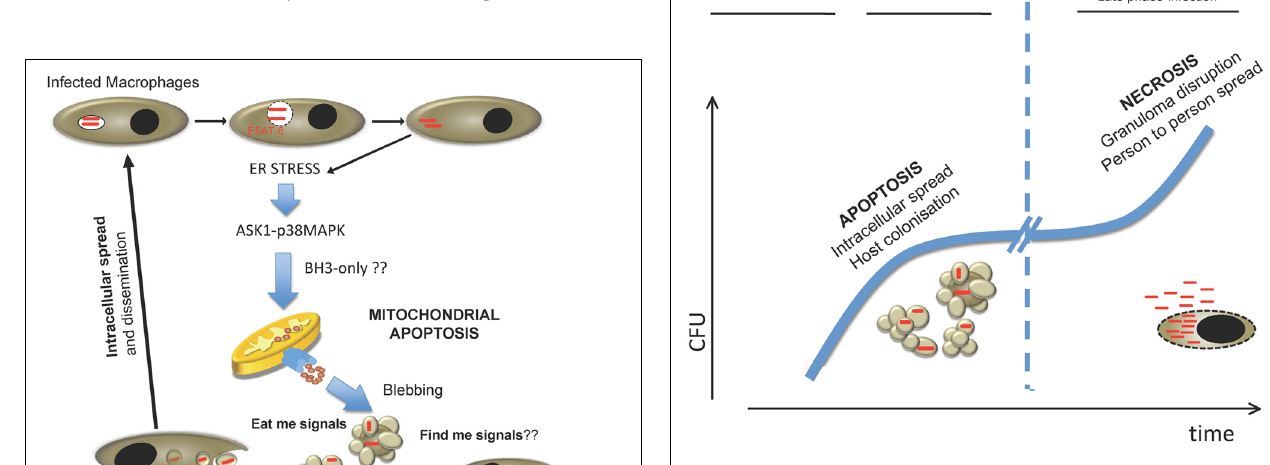
FIGURE 3 | Model of how cell death is involved in the different stages of M. tuberculosis host infection. In the early stages of infection, killing of macrophages by apoptosis would allow M. tuberculosis to spread cell-to-cell in the lung in the absence of inflammatory mediators associated with necrotic release of intracellular content. This would permit bacteria to replicate in the preferred intracellular environment prior to establishment of an effective adaptive immune response. In the latest stages of infection, when bacterial burden is high, M. tuberculosis would induce necrosis on infected cells leading to mycobacterial release to the extracellular medium. As a consequence, granuloma is disrupted allowing aerosol transmission to new